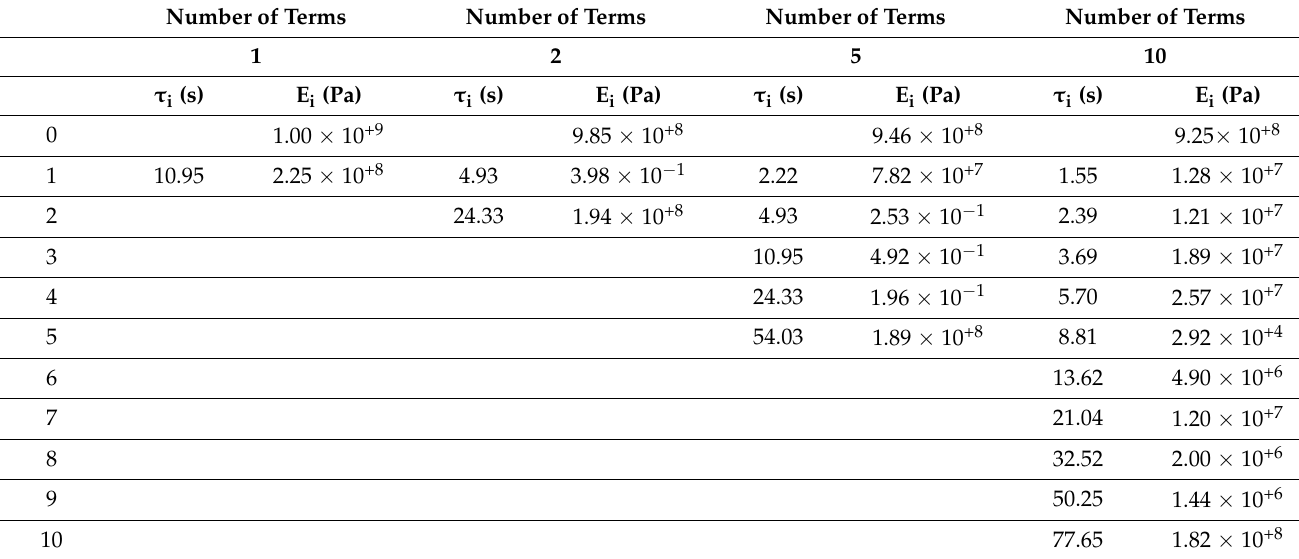
Table 4. Prony series for ABS material and layer printing d = 0.19